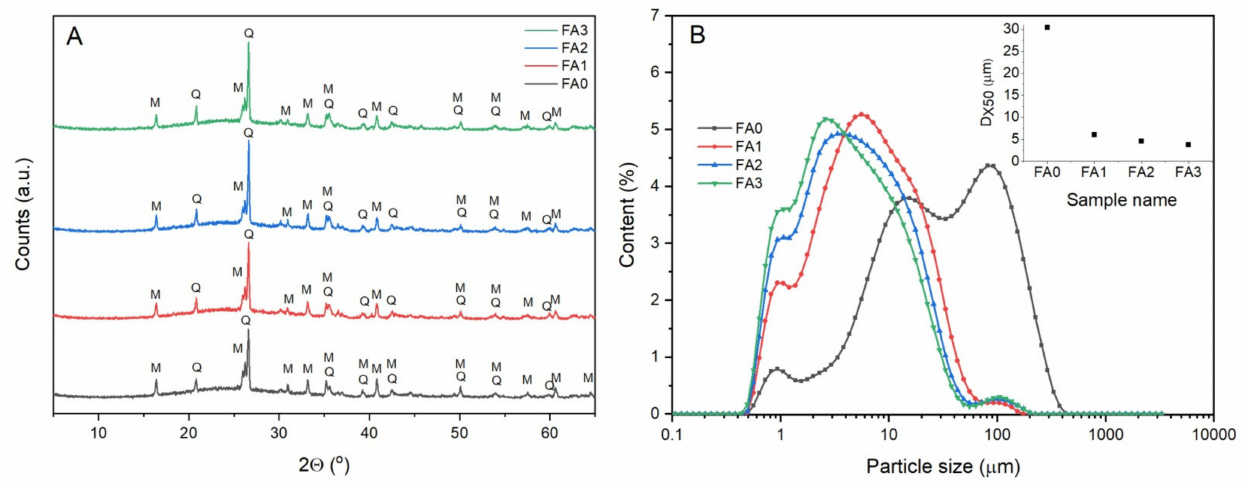
Figure 2. ( A ) XRD patterns, and ( B ) particle size distribution (PSD) (inset is the mean particle size Dx50) of raw and milled FA